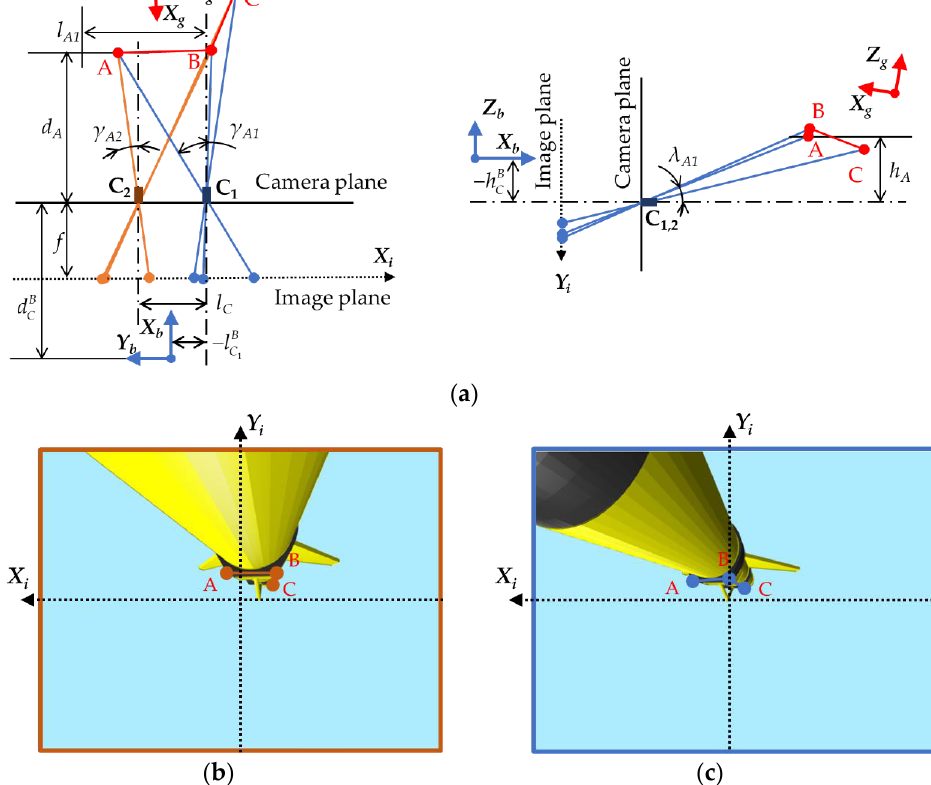
Figure 5. A 6-dimensional pose estimation of the glider in the capturing stage: ( a ) Schematic drawing of the measurement using the stereo camera; ( b ) projected points in the left image (camera C 2 ); ( c ) projected points in the right image (camera C 1 ).